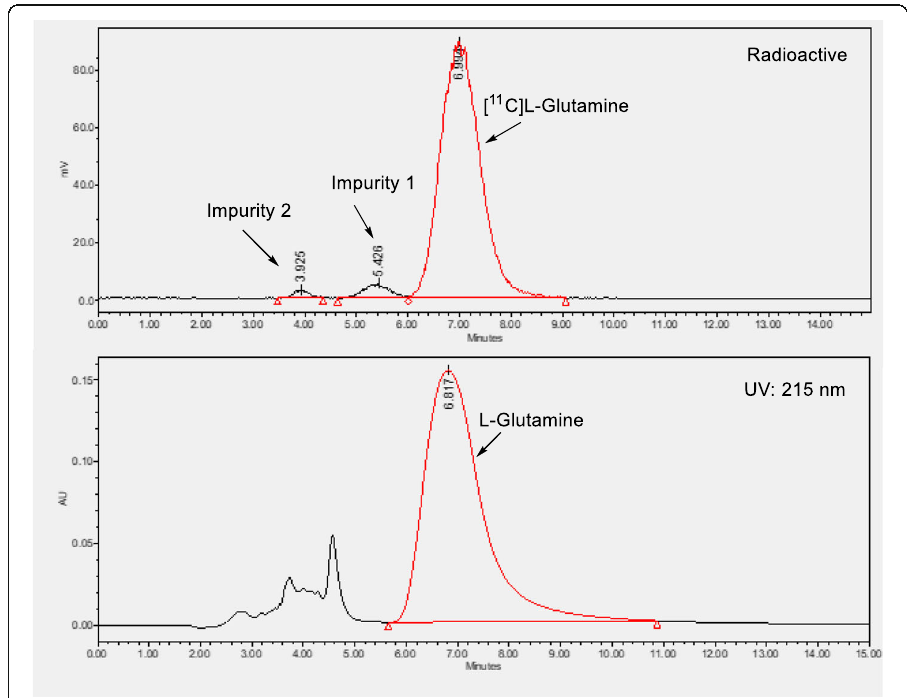
Fig. 2 HPLC chromatograms of C-11